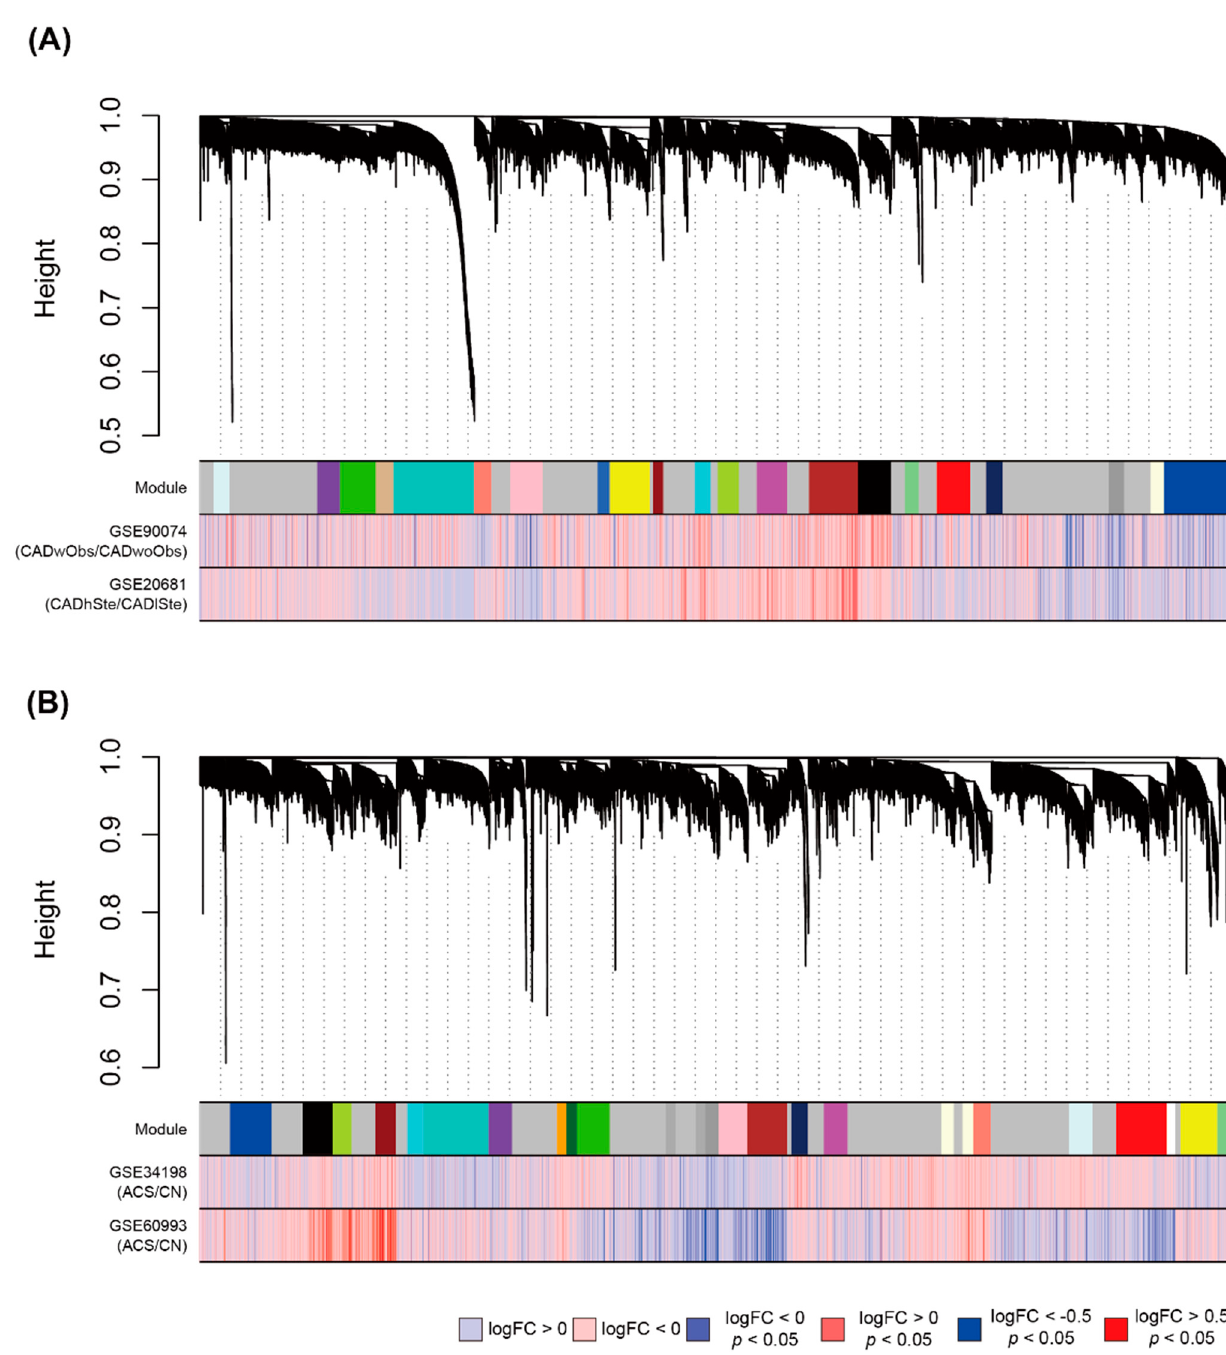
Figure 3. Establishment of modules via weighted gene co-expression network analysis (WGNCA). ( A ) Use of GSE90074 and GSE20681 for construction of CAD obstruction-related modules and ( B ) use of GSE34198 and GSE60993 for construction of ACS-related gene sets. Modules include genes with high correlation based on biweight midcorrelation and are depicted with different colored planes. Each plane consists of numerous lines of the same color, with a single line representing a gene. Color bars in the lower part indicate fold change (FC) values (logFC) between two conditions calculated by the limma package. Height indicates “1 − (topological overlap)”, described by the network dendrogram. Abbreviations: FC, fold change; CAD, coronary artery disease; CADwObs, CAD with obstruction; CADwoObs, CAD without obstruction; ACS, acute coronary syndrome; CN: matched control.